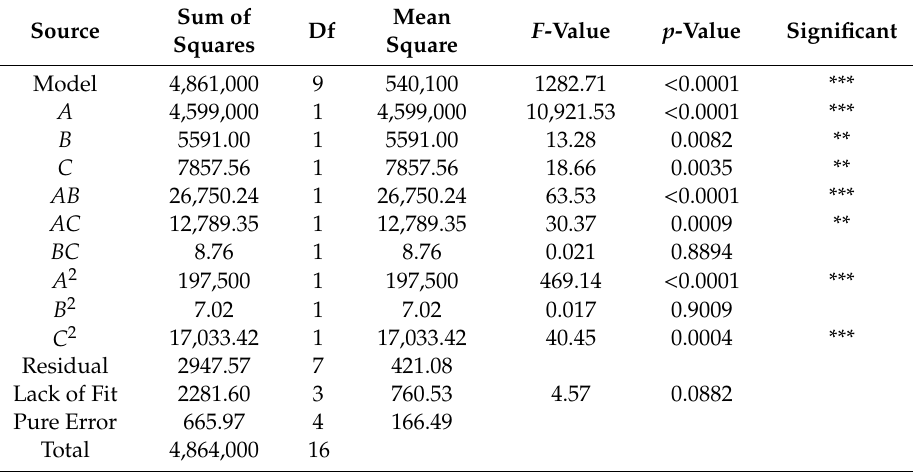
Table 4. Analysis of variance table for the Q il .